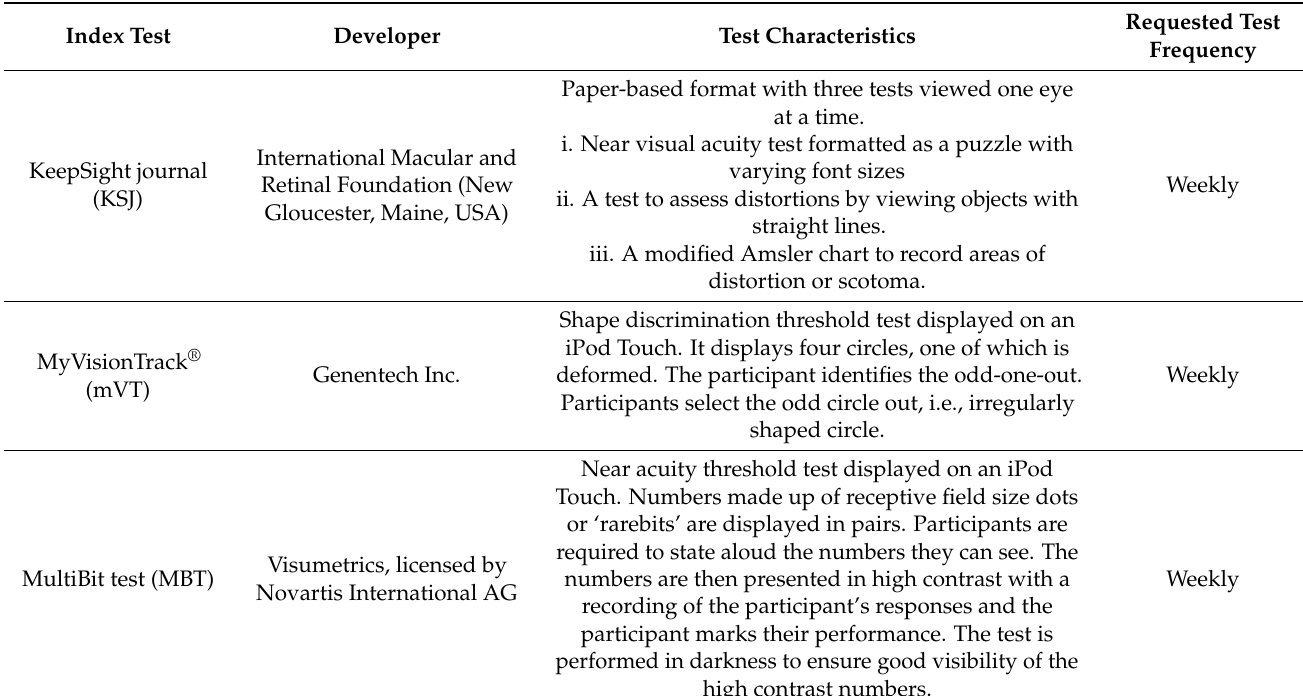
Table 1. Characteristics of index tests used in the MONARCH Study: the paper-based KeepSight journal (KSJ), the MyVisionTrack ® and the MultiBit